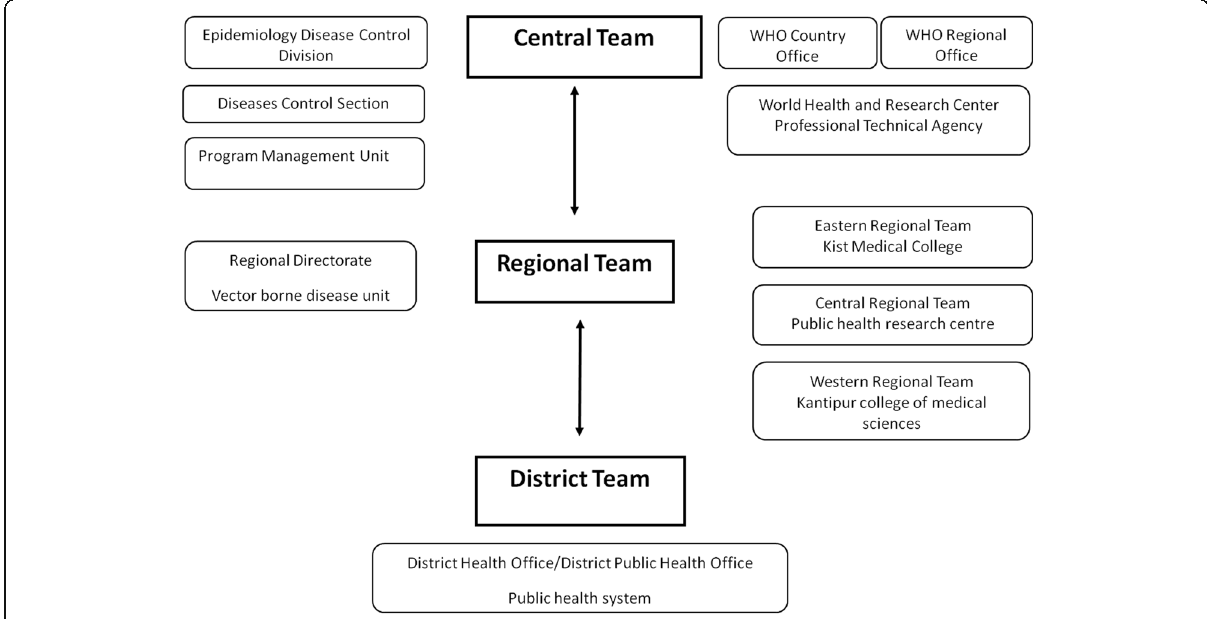
Fig. 1 Composition and network of malaria micro-stratification